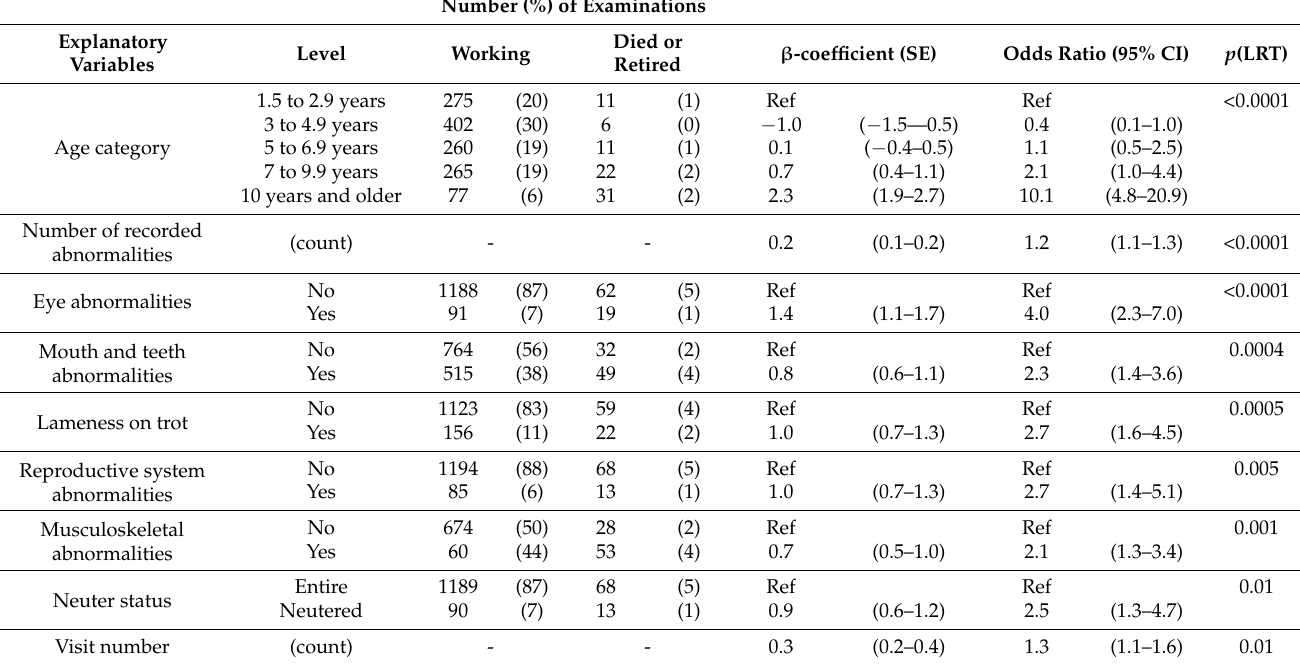
Table 8. The results of univariable logistic regression models examining the risk of each visit being followed by dogs dying or being retired in relation to a range of explanatory variables. β -coefficients (with standard errors (SE)) and odds ratios (with 95% CIs) derived from the logistic regression models and p -values derived from log-likelihood ratio tests. Explanatory variables with p < 0.2 are reported. Data are from 1360 examinations of 589 dogs, of which 81 examinations were followed by a dog dying or being retired. All dogs were enrolled in the TeamMate project and all examinations had recorded values for all tested variables.